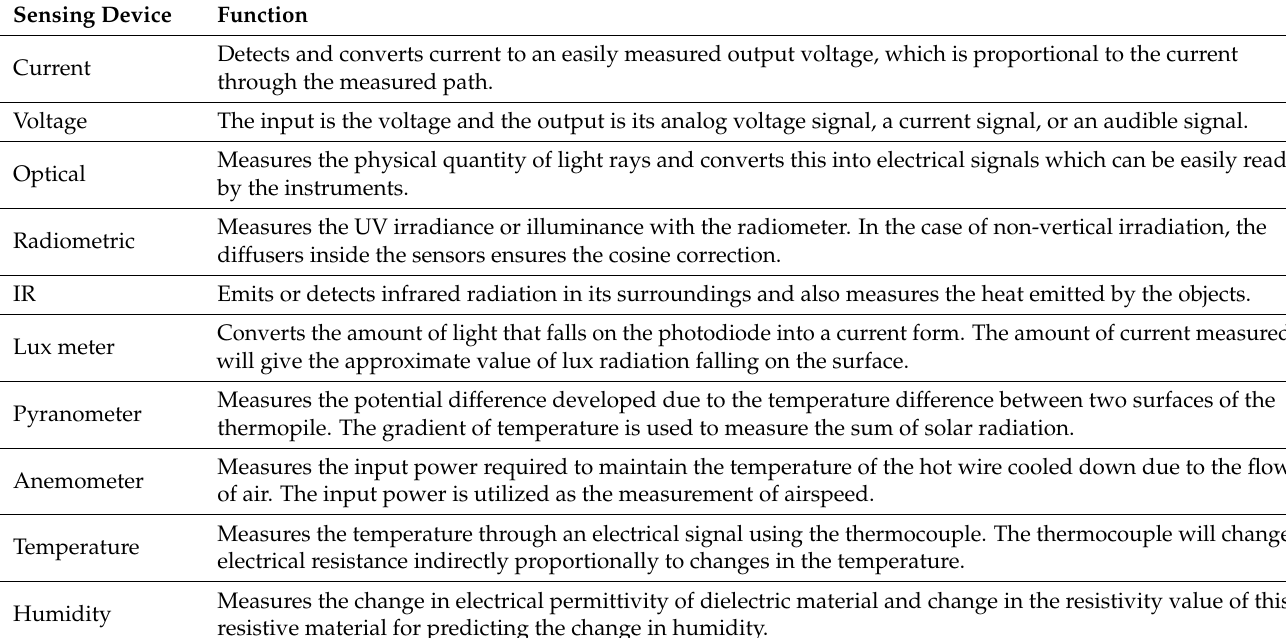
Table 1. Different sensing devices used in